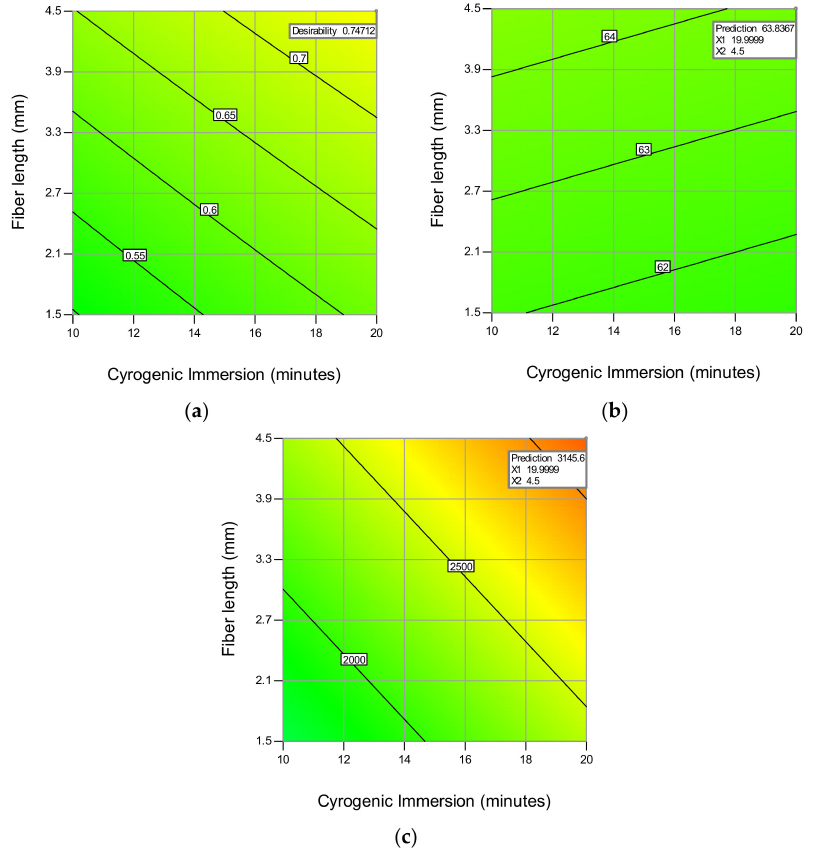
Figure 5. Optimized responses defined by desirability function: ( a ) desirability; ( b ) optimized flexural strength; ( c ) optimized flexural